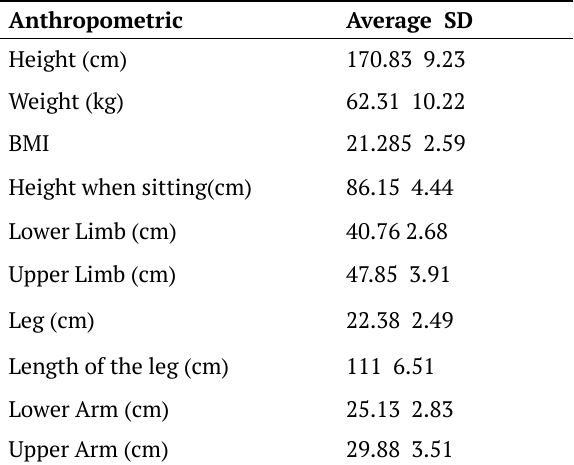
Table 1. Data of anthropometric characteristics of the